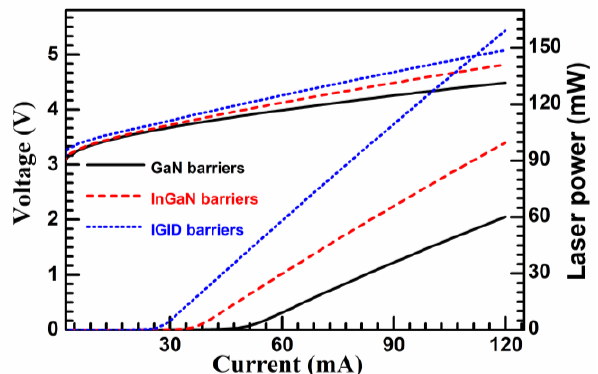
Figure 2. The laser power vs. current–voltage (L–I–V) characteristic curves for the three LD struc- tures.